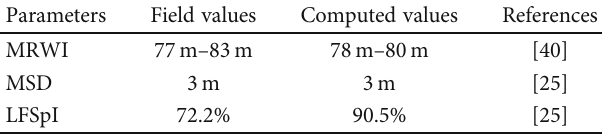
Table 2: Calibration parameters of numerical